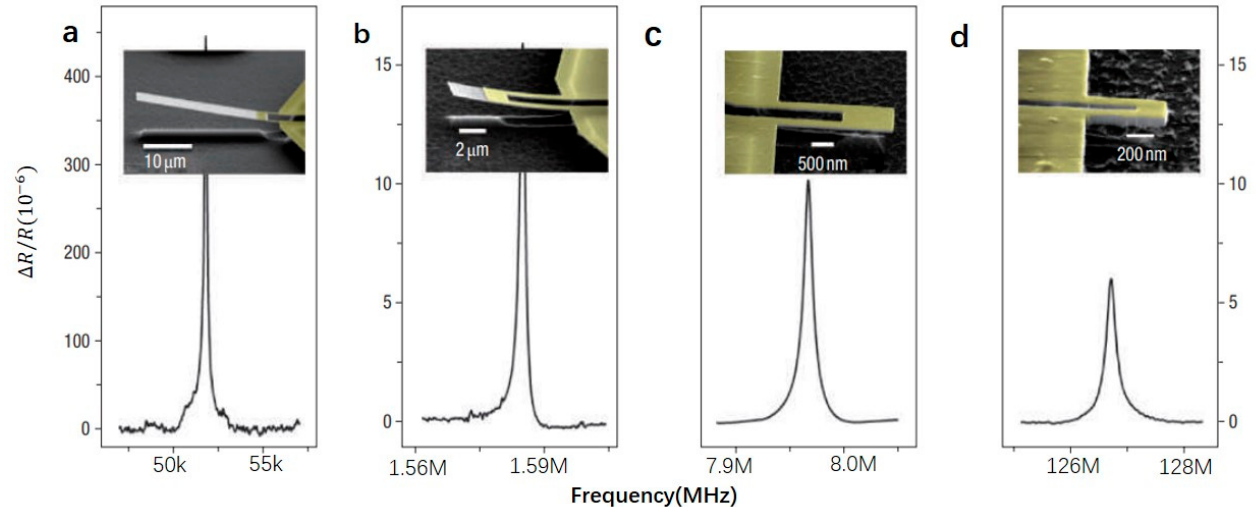
Figure 4. Fundamental-mode resonance frequencies of SiC nanobeams. Adapted with permission from [1]. ( a ) 52.1 k, 33 μm × 5 μm. ( b ) 1.6 MHz, 10 μm × 2 μm. ( c ) 8 MHz, 2.5 μm × 0.8 μm. ( d ) 127 MHz, 0.6 μm × 0.4 μm. The inset is the SEM image of cantilever beam.